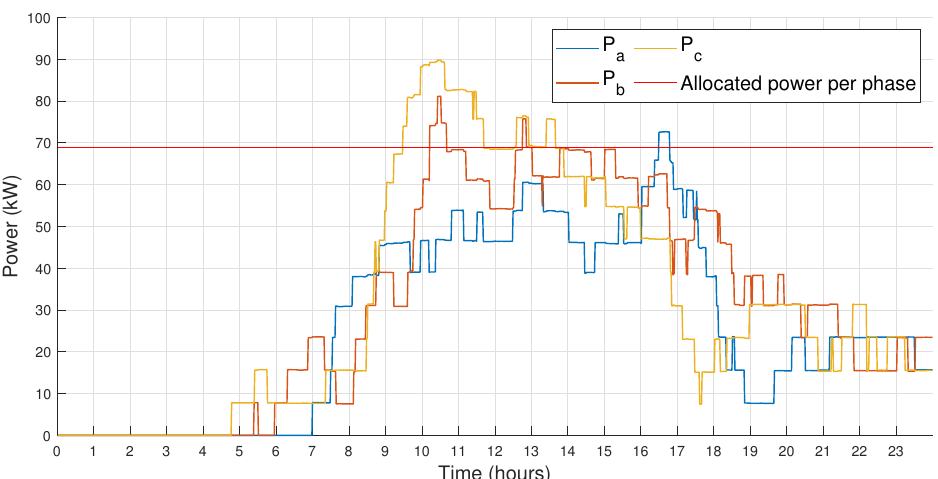
Figure 8. Total power per phase consumed by the charging infrastructure during the simulated